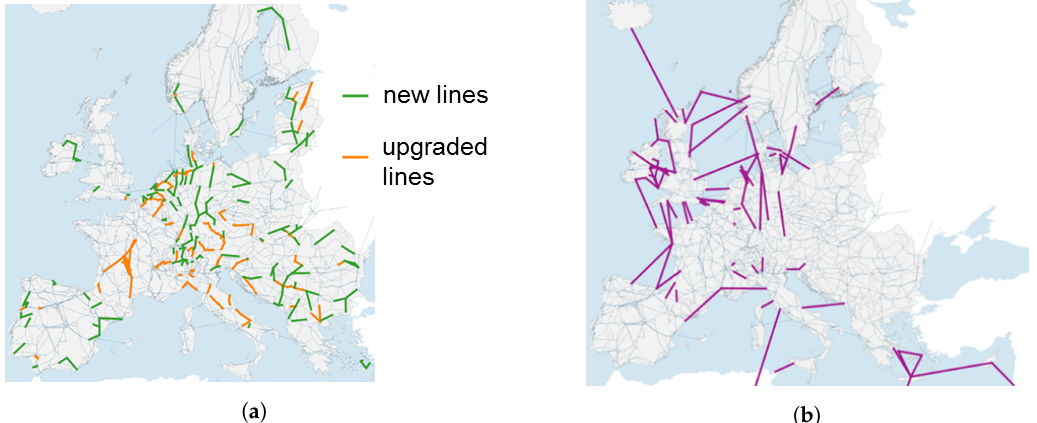
Figure 2. Projects proposed by the TYNDP 2016 [33], as implemented in Europower. ( a ) AC lines; ( b ) DC